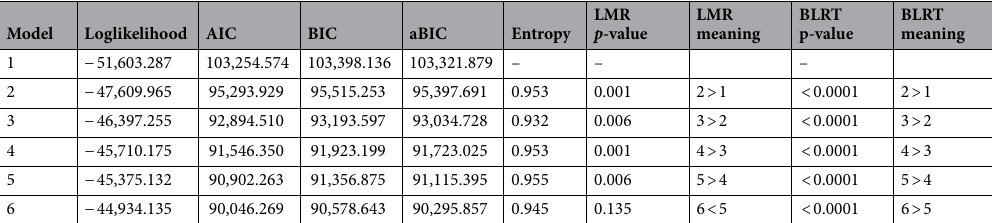
Table 1. Latent profile model fit indices (n = 2927).